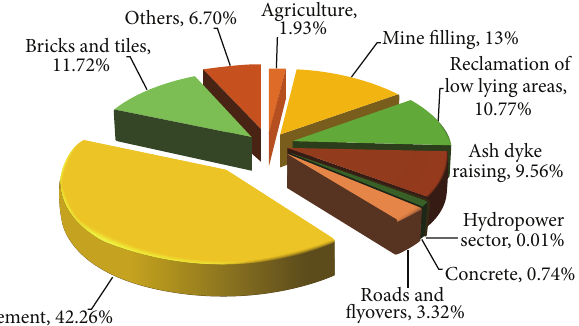
Figure 1: Modes of utilization of FA in the year 2014-15 [1].